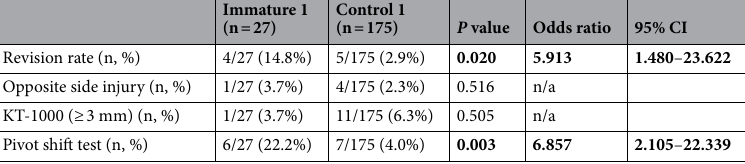
Table 3. Postoperative outcomes following anterior cruciate ligament reconstruction. The chi-square test was used. Odds ratio was analyzed in case of statistical analysis. CI confidence interval. The bold values represent the significant difference, which p values were less than 0.05.